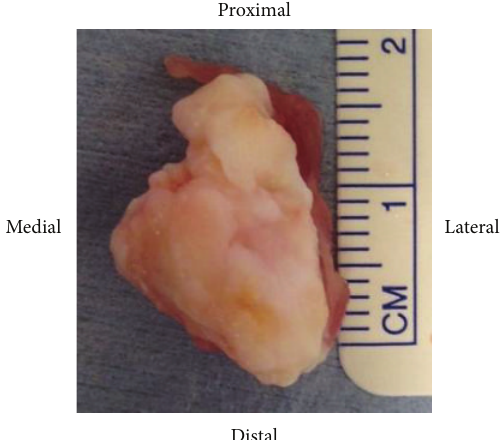
Figure 4: Gross pathology of the excised fabella, confirming signif- icant